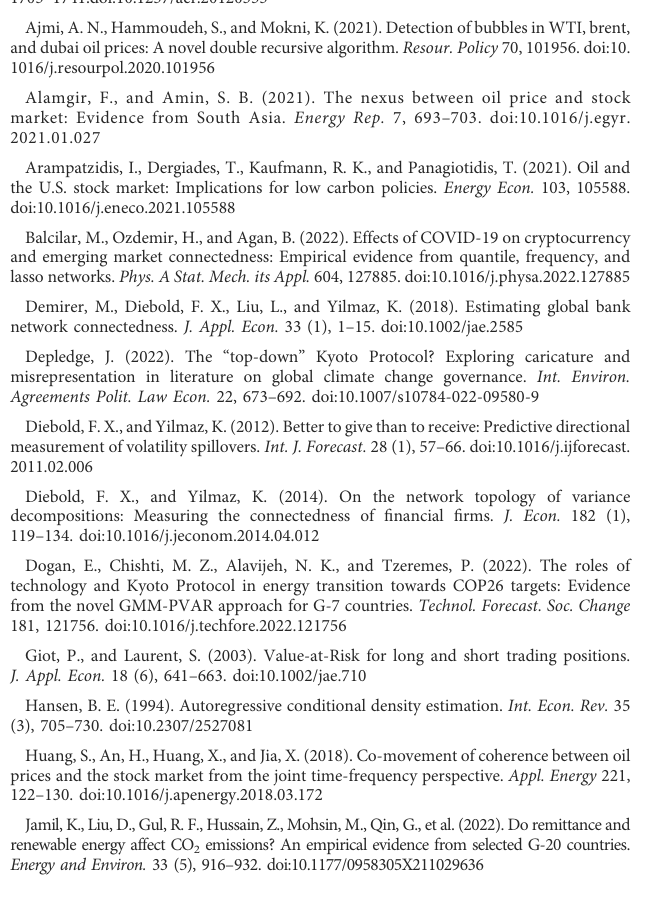
SUPPLEMENTARY FIGURE A1 Directional spillovers: TO all others (1st commitment period). SUPPLEMENTARY FIGURE A2 Directional spillovers: TO all others (2nd commitment period). SUPPLEMENTARY FIGURE A3 Directional spillovers: FROM all others (1st commitment period). SUPPLEMENTARY FIGURE A4 Directional spillovers: FROM all others (2nd commitment period). SUPPLEMENTARY TABLE A1 Estimates of marginal distribution models (1st commitment period). SUPPLEMENTARY TABLE A2 Estimates of marginal distribution models (2nd commitment period). SUPPLEMENTARY TABLE A3 Directional risk spillovers based on static network. SUPPLEMENTARY DATA SHEET 1 Closing prices of oil and stock